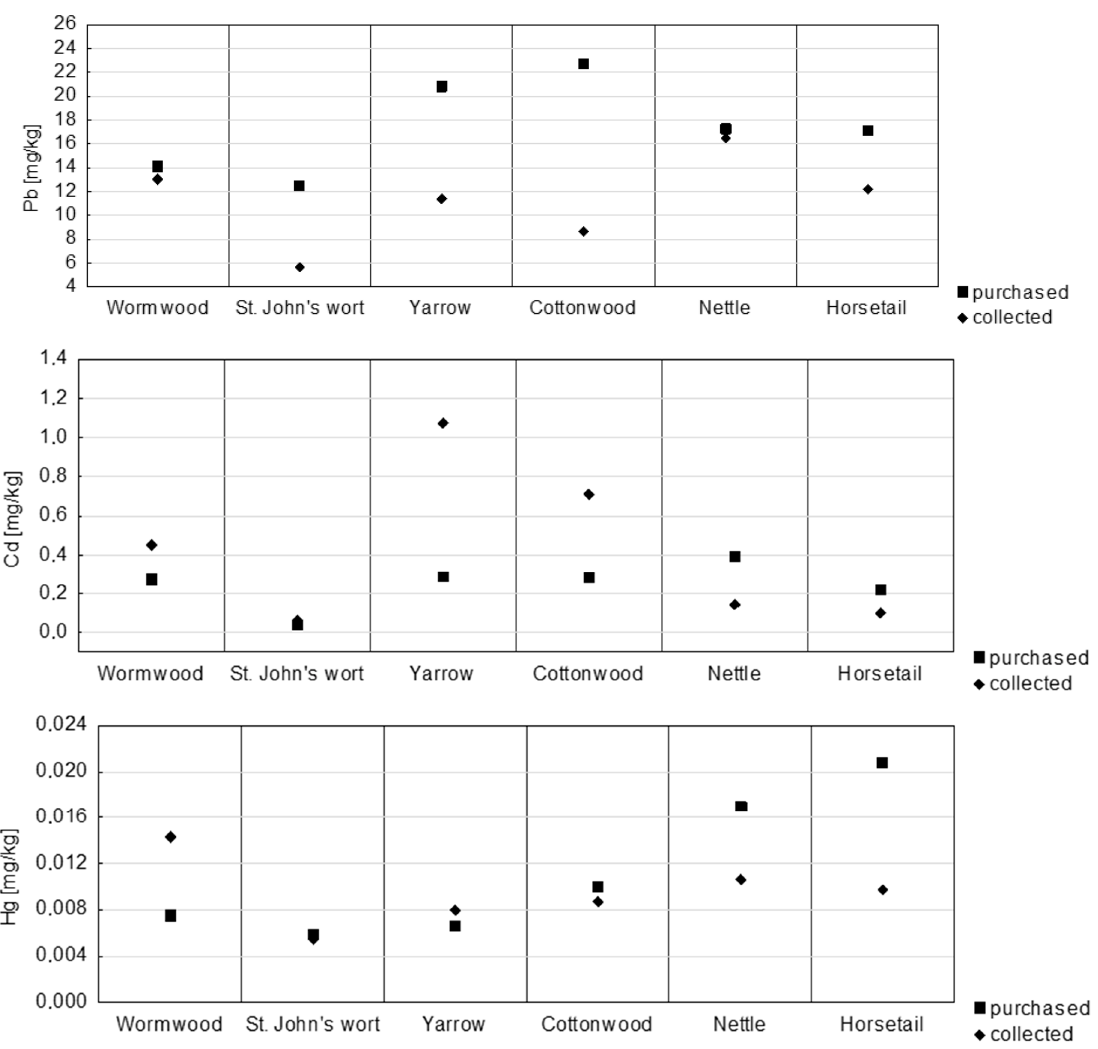
Figure 2. Comparison of concentration of Pb, Cd and Hg in self-collected and purchased plants (mg/kg).